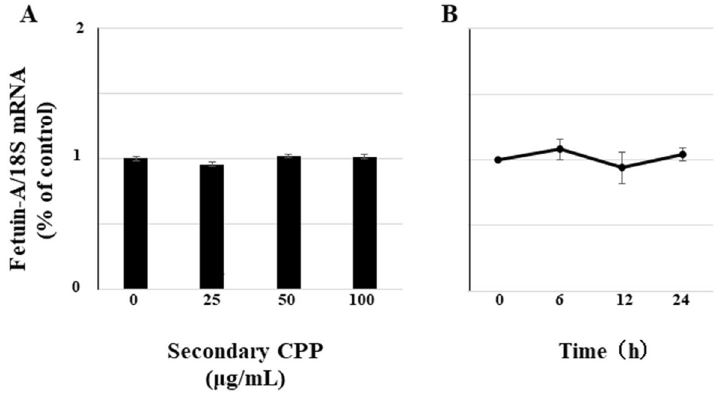
Figure 2. Effects of secondary CPP on expression of fetuin-A mRNA in HepG2 cells. ( A ) HepG2 cells were treated with different concentrations (0, 25, 50, and 100 μg/mL) of synthetic secondary CPP for 24 h. ( B ) HepG2 cells were treated with 100 μg/mL secondary CPP for 0, 6, 12, 24 h. Total RNA was isolated from cells and fetuin-A/ahsg mRNA expression was determined using quantitative real-time PCR. Levels of fetuin-A mRNA were calculated using the comparative cycle threshold method, with 18S ribosomal RNA as the endogenous reference. Fetuin-A mRNA levels without secondary CPP ( A ) or at 0 h ( B ) were defined as 100% (control). Data are shown as mean ± SD from at least three independent experiments. *P < 0.05 vs. control.